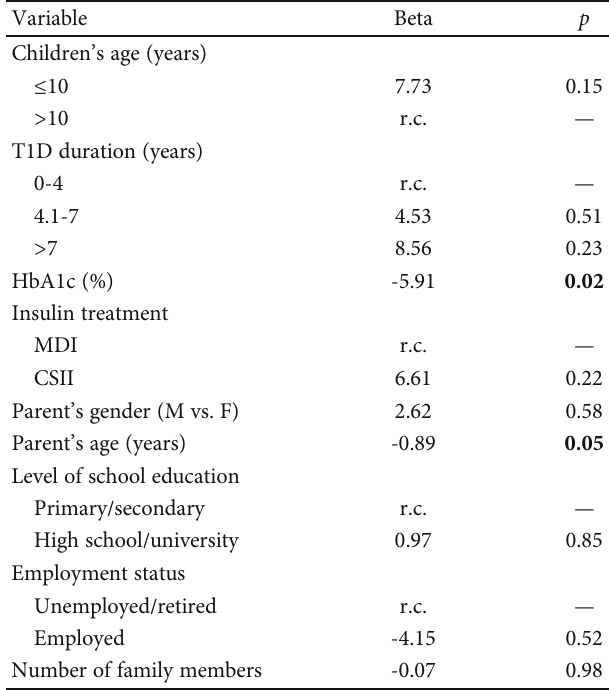
Figure 2: Estimated mean scores in fathers. Asterisks indicate signi fi cant di ff erences between species (planned comparisons; ∗∗∗ p < 0 : 05 ). Abbreviations: M1 — after one month; M3 — after three months; PSI-SF — Parenting Stress Index Short Form; DRD — Diabetes-Related Distress; HSF — Hypoglycemia Fear Survey; PF — physical function; RP — role limitations due to physical problems; BP — bodily pain; GH — general health; VT — energy/vitality; RE — role limitations due to emotional problems; SF — social functioning; MH — mental health; PCS — physical component summary; MCS — mental component summary; PHLOC — Parent Health Locus of Control Scale. Table 4: Correlates of changes in PSI-SF score: results of multiple regression